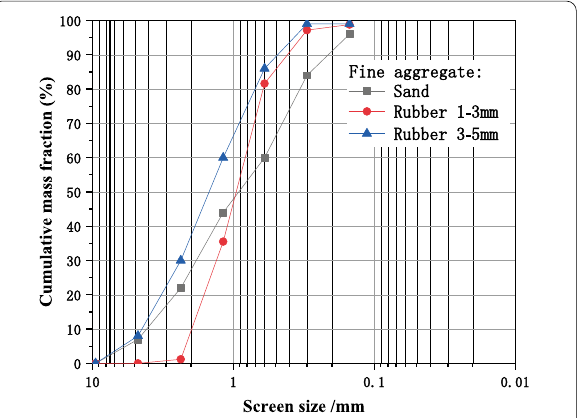
Fig. 2 Grading curves of the river sand and the two types of